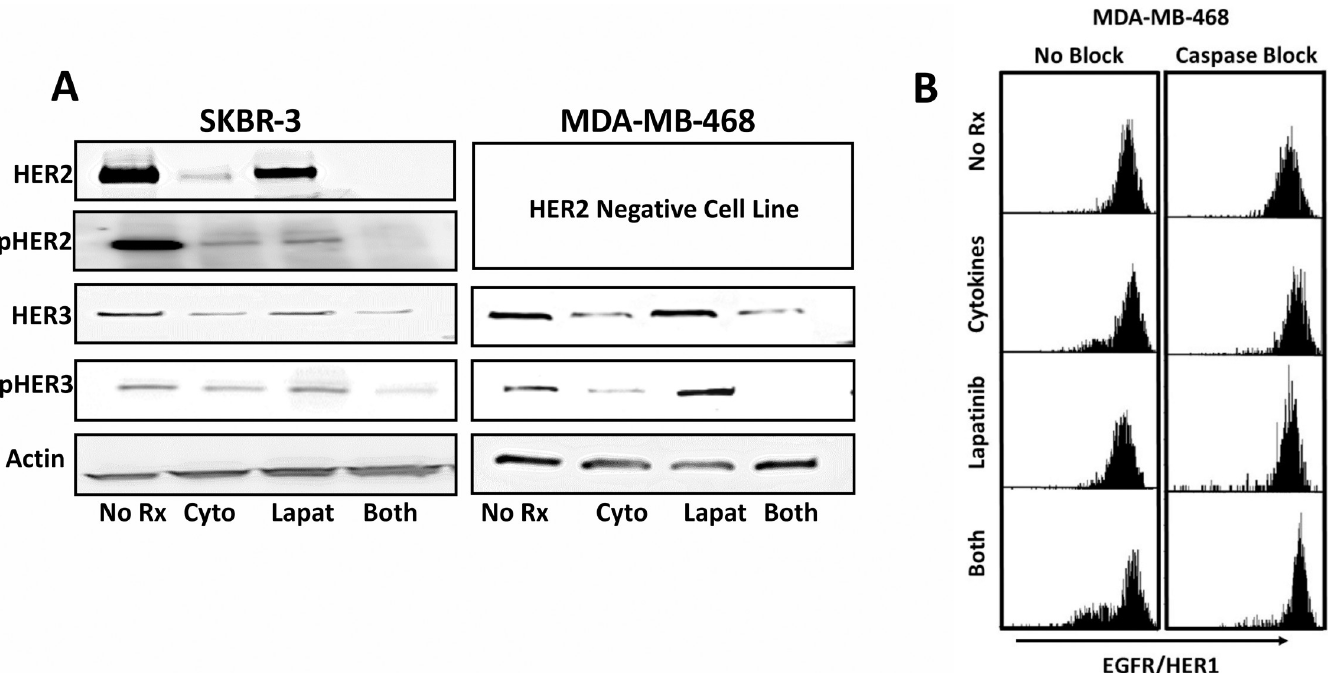
Fig 4. Lapatinib and Th1 cytokines suppress HER-family RTK expression and phosphorylation status. SK-BR-3 and MDA-MB-468 cells were treated with either Th1 cytokines (TNF- α plus IFN- γ ; 20 and 12.5ng/ml respectively), 200nM Lapatinib, Th1 cytokines plus Lapatinib, or left untreated (control). A) After 72 hours incubation the cells were harvested, extracted in presence protease and phosphatase inhibitors, and 30 μ g/well total proteins separated on a 4–15% gradient SDS-PAGE gel prior to electrotransfer onto nitrocellulose membranes. Blots were then probed with anti-HER2, anti-phospho-HER2, anti-HER3 and anti-phospho-HER3 antibodies, and bands detected using chemiluminescence. B) After 24 hours, MDA-MB-468 cells treated as in (A) were supplied with caspase antagonist Z-DEVD-F. After 72 hours total culture cells were harvested and stained with EGFR antibody conjugated to PE/Dazzel 594 and analyzed for EGFR expression via flow cytometry.